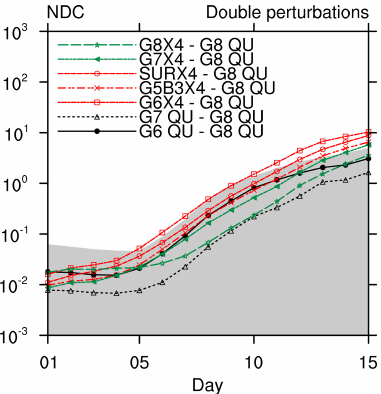
Figure 7. The same as Fig. 5 but for the baroclinic wave test with double perturbations and only for the nonhydrostatic